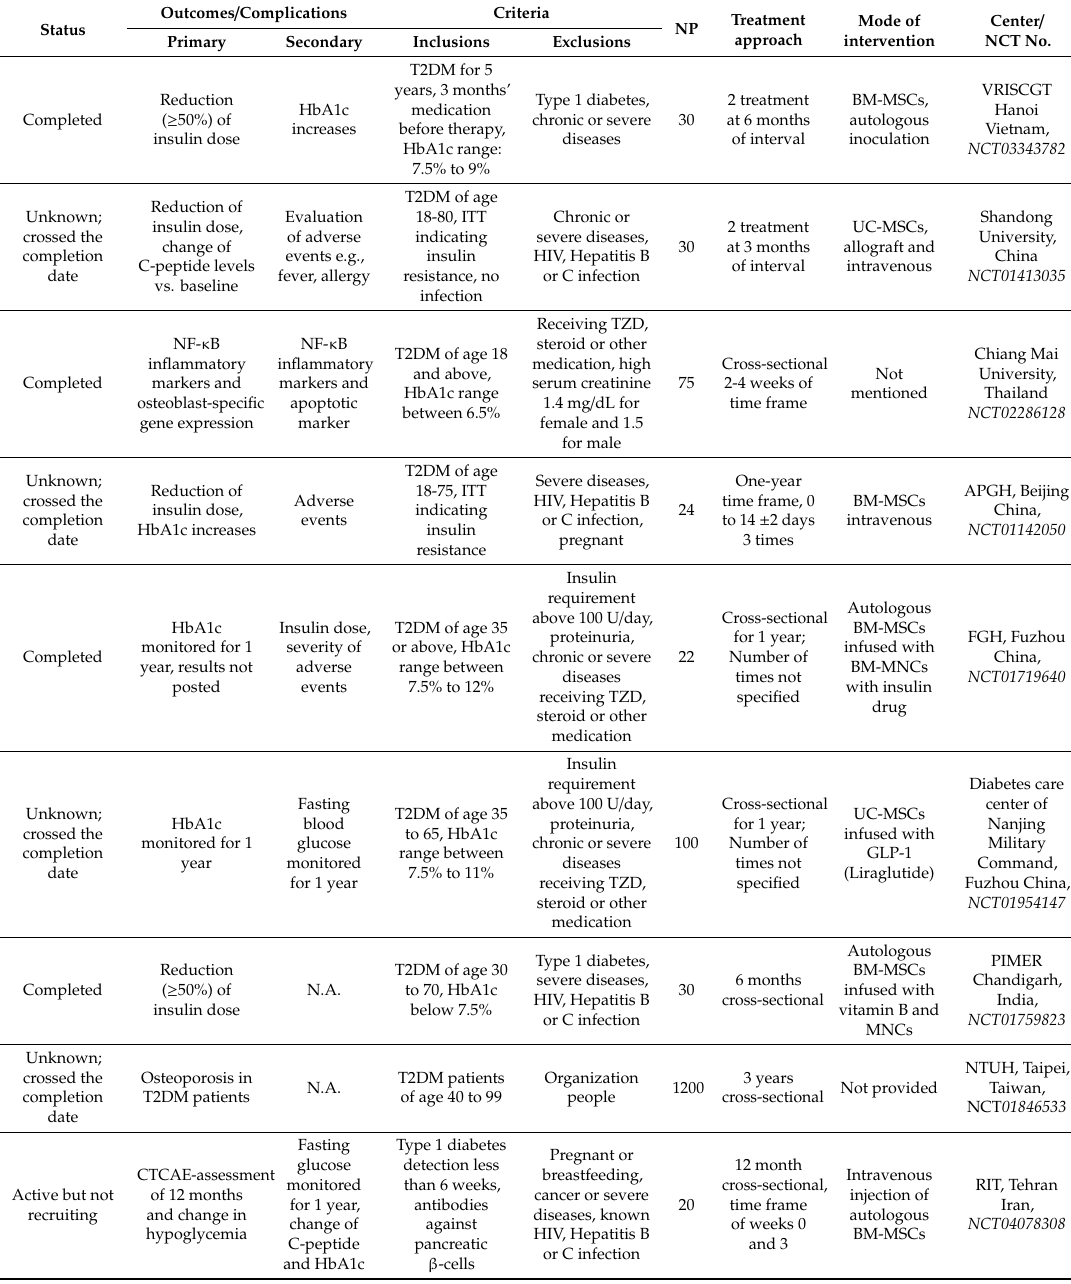
Table 2. Details of the clinical trials using MSCs on diabetes